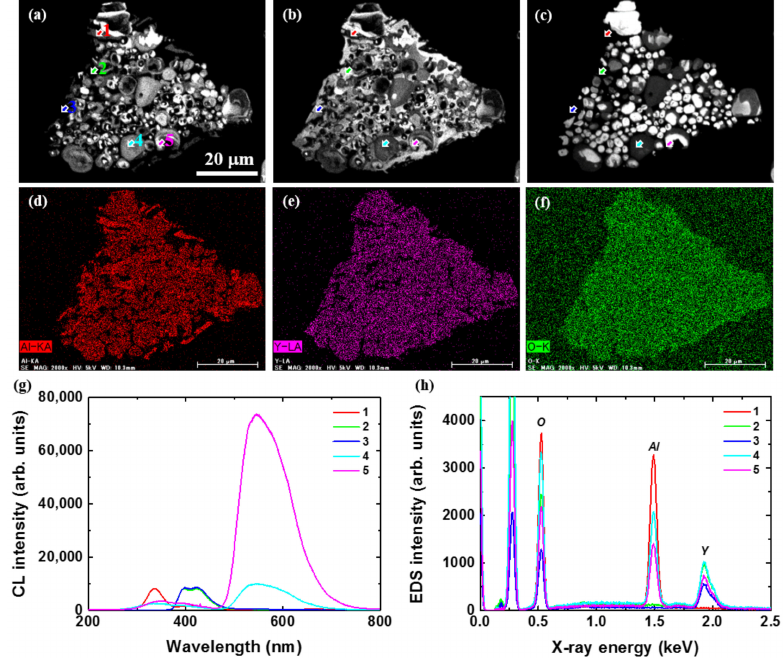
Figure 8. Cross-sectional CL images taken at 330 ( a ); 395 ( b ) and 540 nm ( c ) and Al ( d ); Y ( e ) and O ( f ) distributions for C@YAG:Ce 3+ -1500 ◦ C/Type B; Local CL ( g ) and EDS ( h ) spectra taken on locations indicated by arrows in the images. In the EDS spectra, the first peak at 0.25 keV is ascribed to the carbon from epoxy resin in the pre-treatment of cutting before doing cross-sectional CL